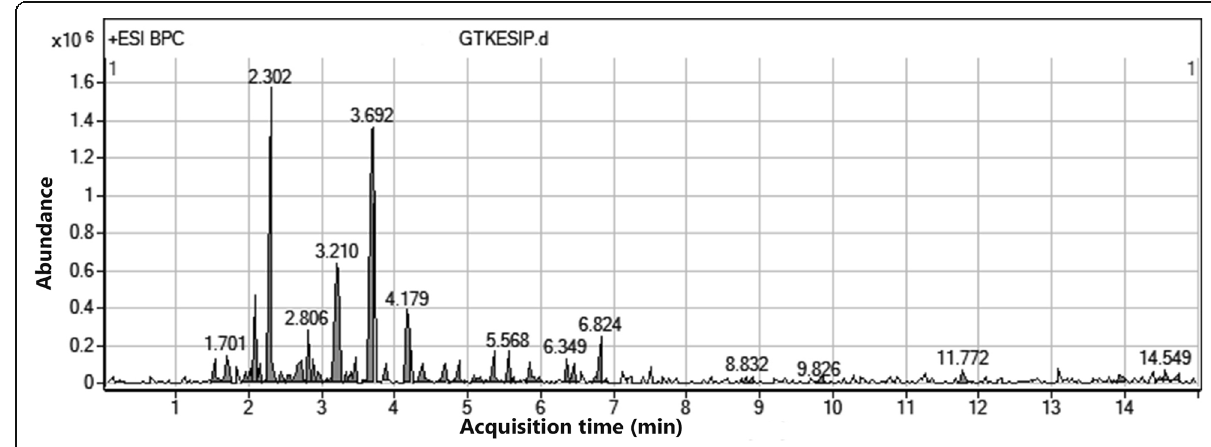
Fig. 2 ESI-MS-base peak chromatogram of GTK in positive ionization